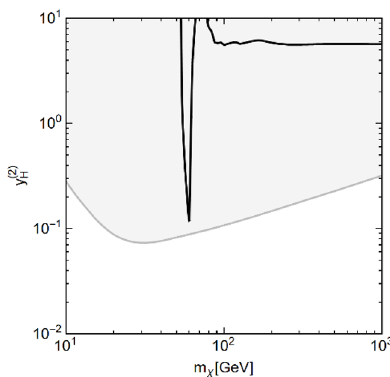
Figure 3 . Isocontours of correct relic abundance and DD limits for the e(cid:11)ective Higgs portal with the same conventions as in (cid:12)gure